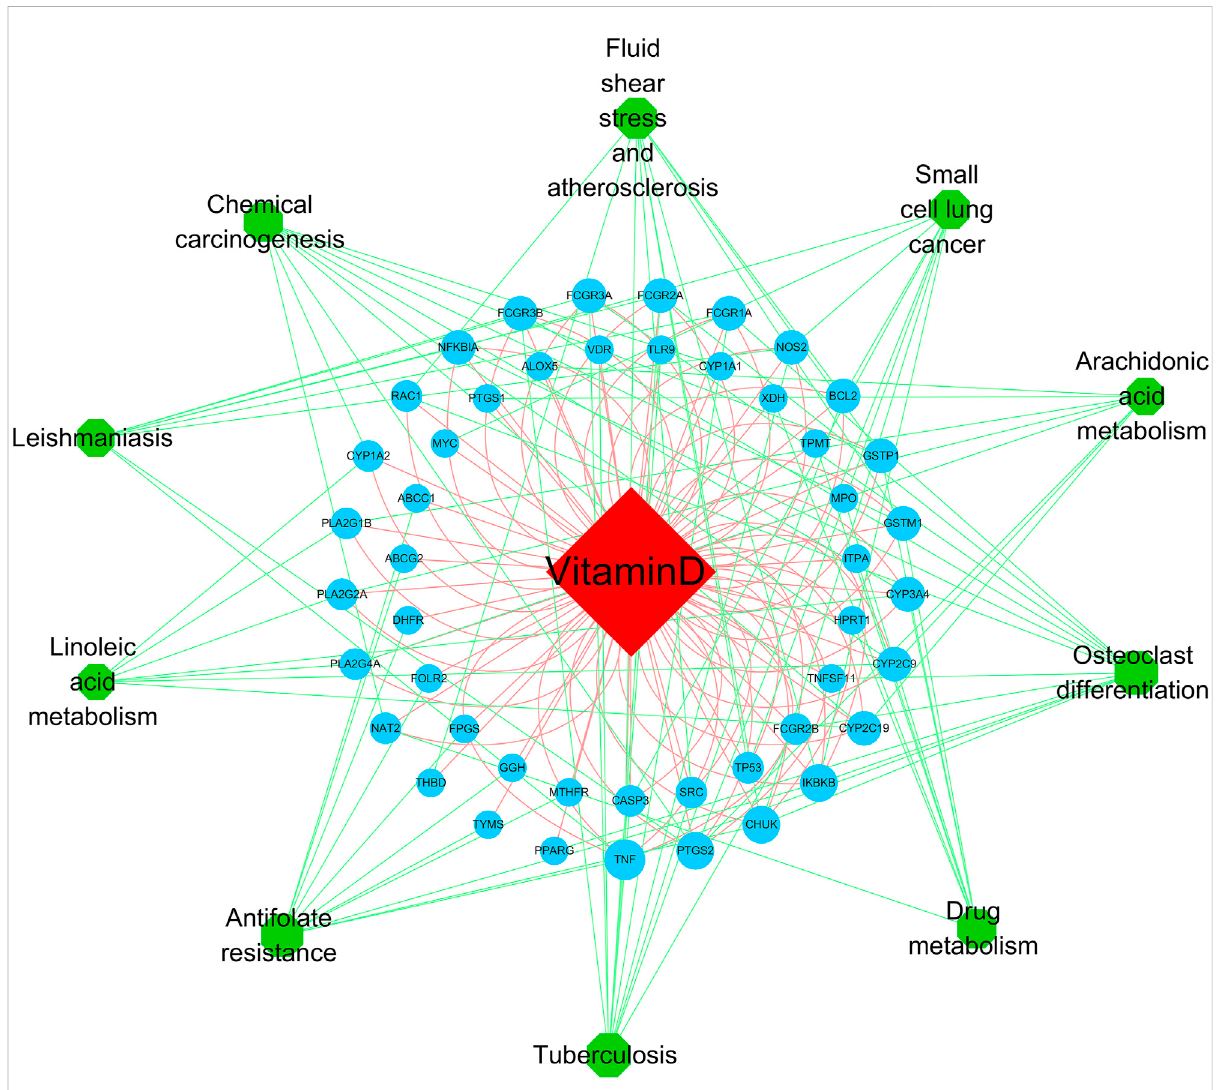
FIGURE 7 The vitamin D – target – pathway diagram of the top 10 pathways. The red diamond represents the drug, the blue circles represent overlapping genes, and the green circles represent pathways, p < 0.05.